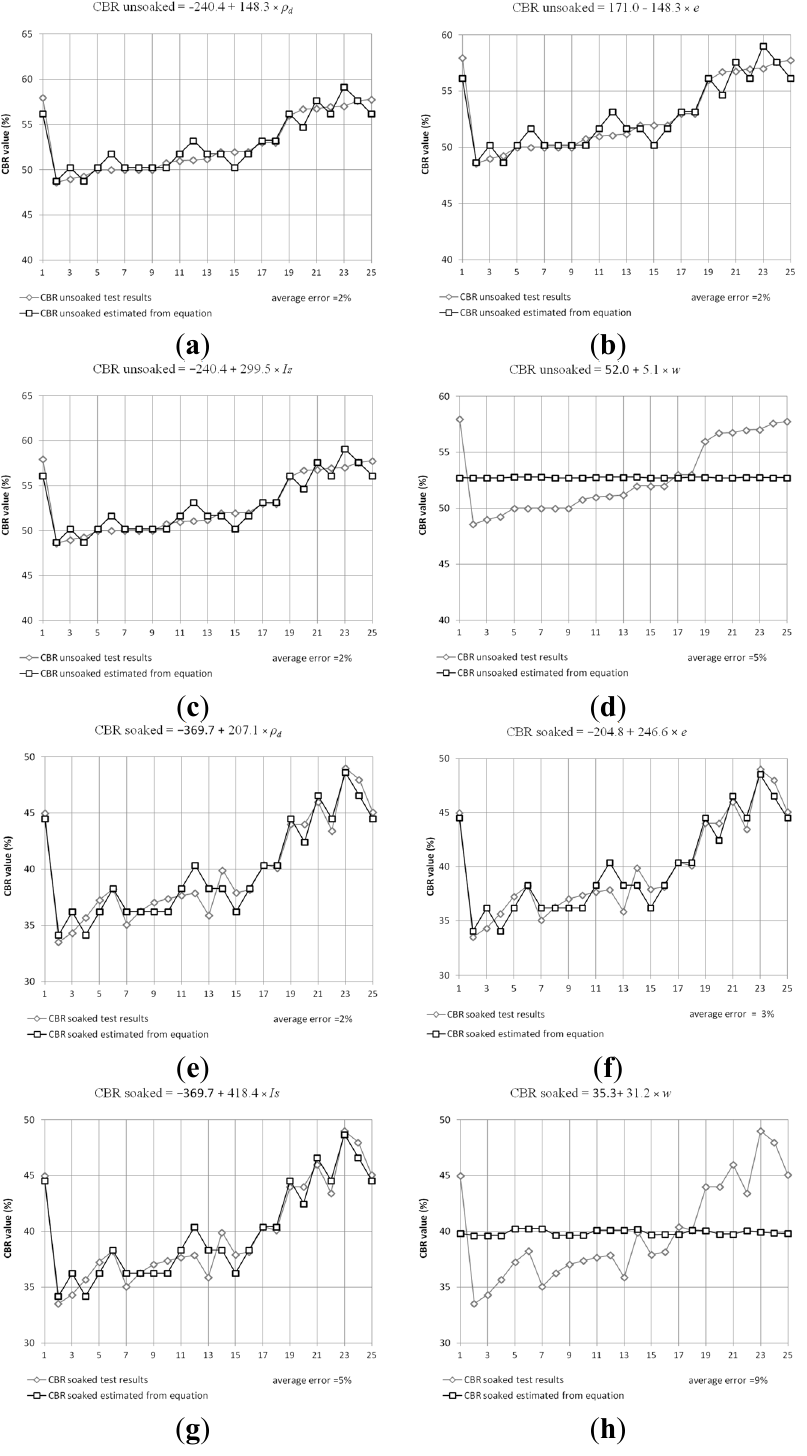
Figure 5. Plot of estimated equations for CBR values and test results for unsoaked test conditions, fraction 2–25 mm. ( a ) CBR unsoaked calculated on the base density. ( b ) CBR unsoaked calculated on the base void ratio. ( c ) CBR unsoaked calculated on the base degree of compaction. ( d ) CBR unsoaked calculated on the base moisture content. ( e ) CBR soaked calculated on the base density. ( f ) CBR soaked calculated on the base void ratio. ( g ) CBR soaked calculated on the base degree of compaction. ( h ) CBR soaked calculated on the base moisture